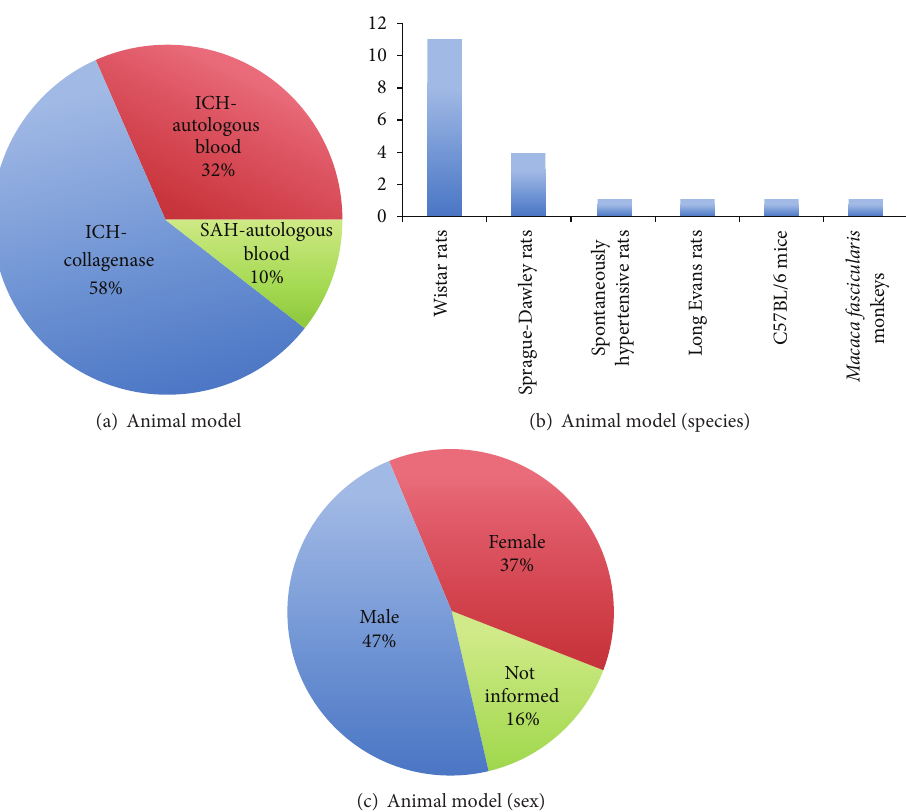
Figure 1: Charts summarizing the animal models (a), species (b), and sex of the animals (c) used in preclinical studies that have evaluated the potential of bone marrow-derived cells to treat hemorrhagic